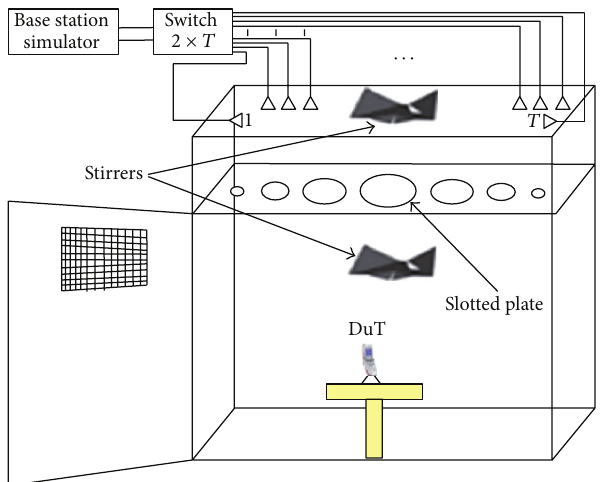
Figure 5: Reverberation chambers with multiple cavities. Repro- duced by permission of EMITE